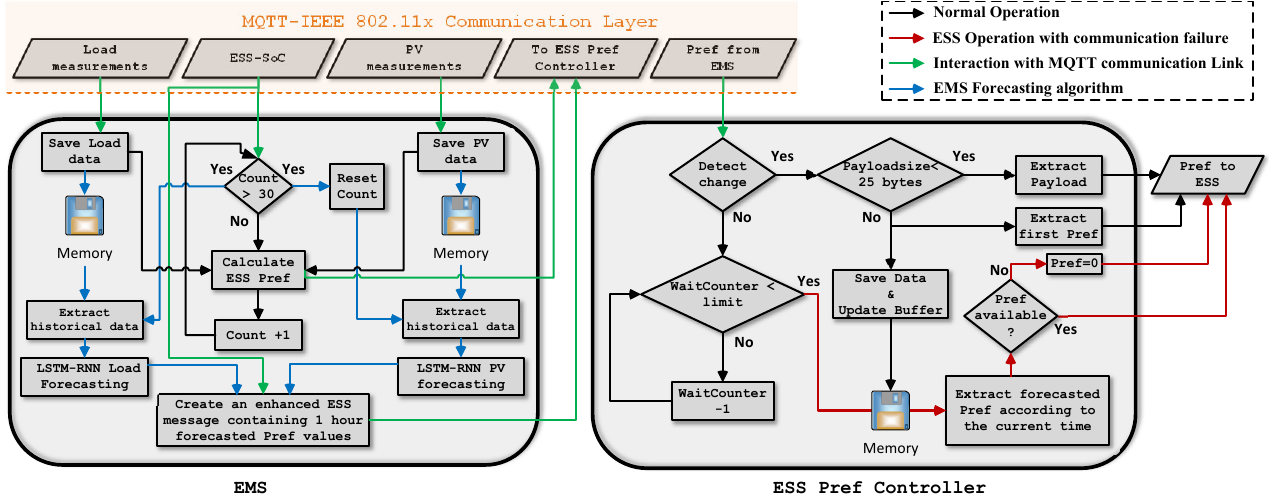
Figure 11. EMS and ESS Pref Controller architecture to transmit and receive enhanced power references with redundant